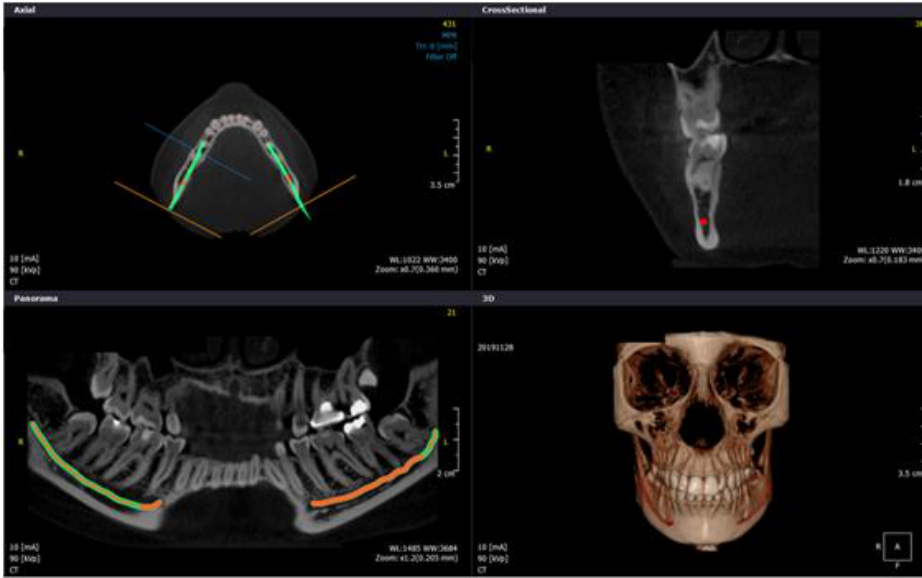
Figure 5. Images of IAN tracing shown using On-Demand 3D computer software with axial plane, panoramic view, transverse cuts and 3D view for dentate subject.